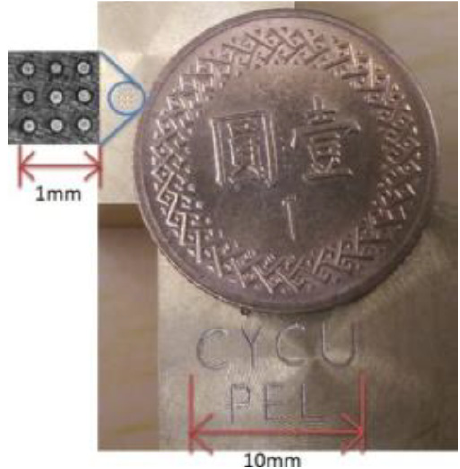
Figure 17. Micro pattern, nine-hole array, and characters.